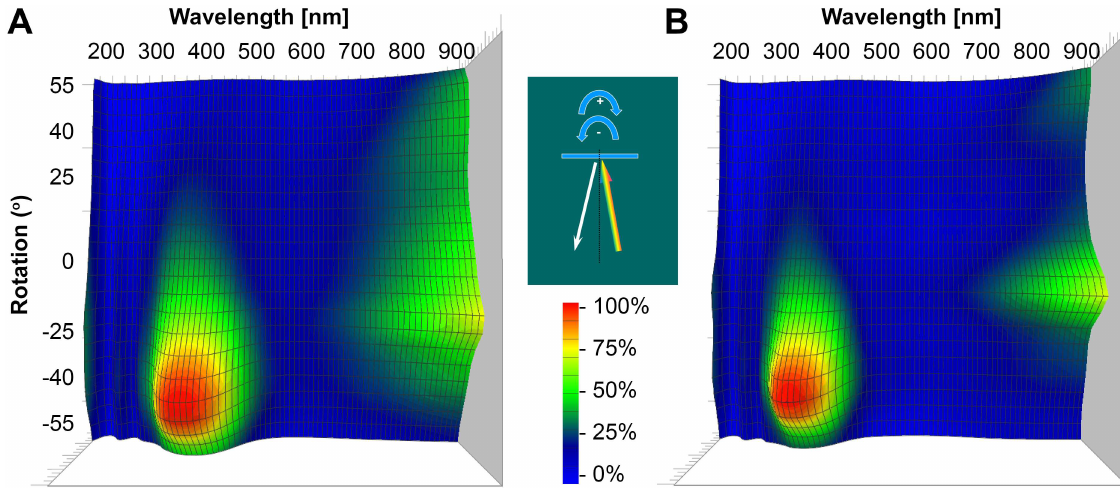
Fig 3. Spectrogoniometric characterization of a P . icarus (A) and of a P . argus (B) wing. Individual spectra recorded in steps of 5˚ are plot as a color-coded3D surface. In the central inset, the measurement geometry is shown schematically. The illuminating beam is shownhaving rainbowcolors, whilethe reflected beam is white. The iridescent behavior of the measuredwings is similar.